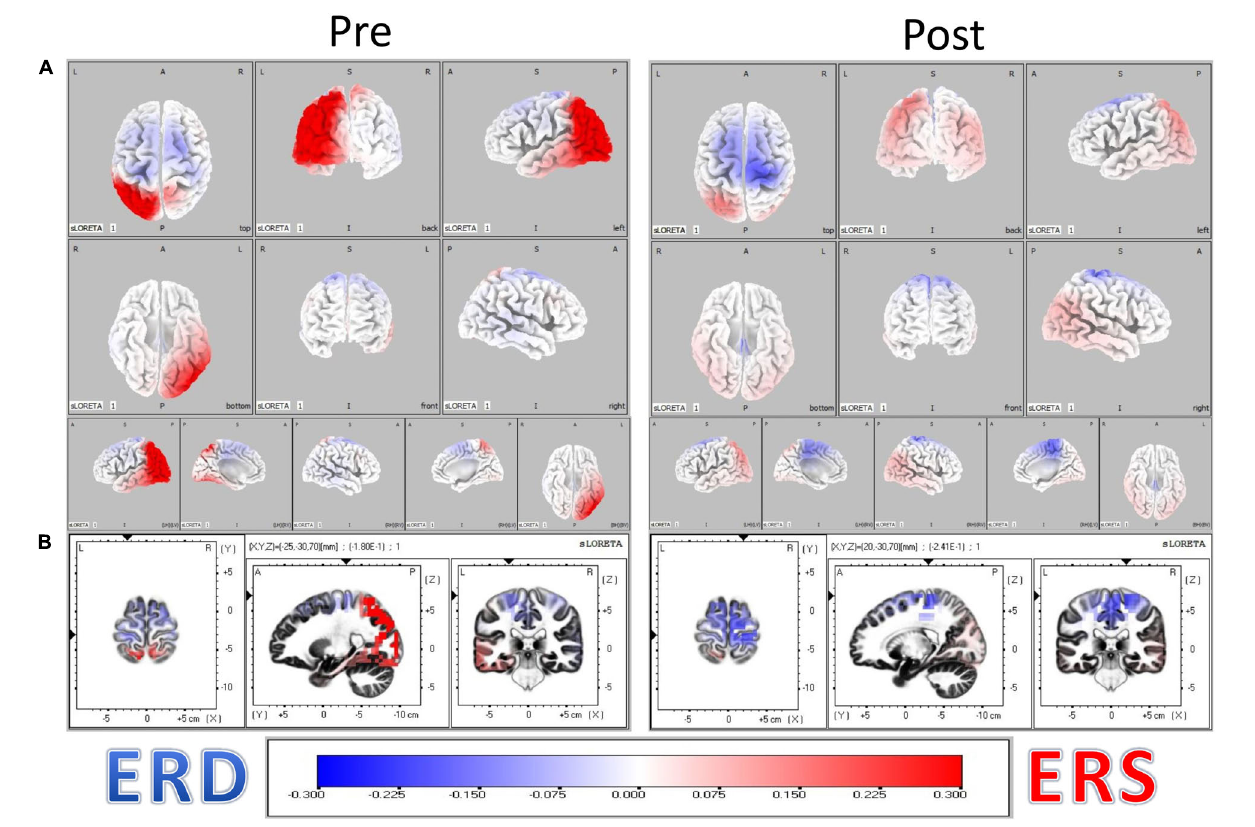
FIGURE 3 | (A) Localization of Mu rhythm desynchronization of cerebral cortical sensorimotor areas during movement of the affected hand compared to rest. Computations are made in a realistic head model using the MNI152 template, with the three-dimensional solution space restricted to cortical gray matter, as determined by the probabilistic Talairach atlas. The specific frequency band cross-spectra (frequency-domain) obtained from the average-reference potential data were the inputs for source localization. The resulting distribution of ERD and ERS heatmaps illustrate the distribution of ERD and ERS changes from Pre to Post BCI intervention in the n = 16 stroke survivors. (B) Obtained eLORETA of Mu band power estimates at 6239 cortical locations (i.e., voxels) normalized across subjects.